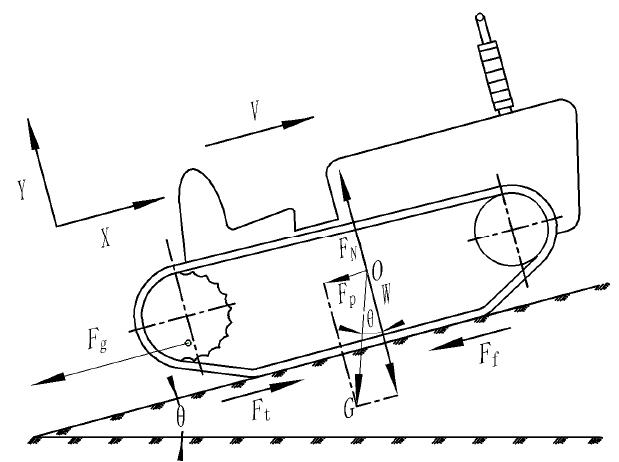
Figure 2. Working force diagram of the hillside crawler tractor. Note: F t is the driving resistance, (N); F f is the rolling resistance, (N); F p is the ramp resistance, (N); F g is the drive resistance, (N); W is the normal load (N); F N is the supporting force from the ground (N); V is the working speed of the tractor, (km/h); O is the center of gravity of the tractor.